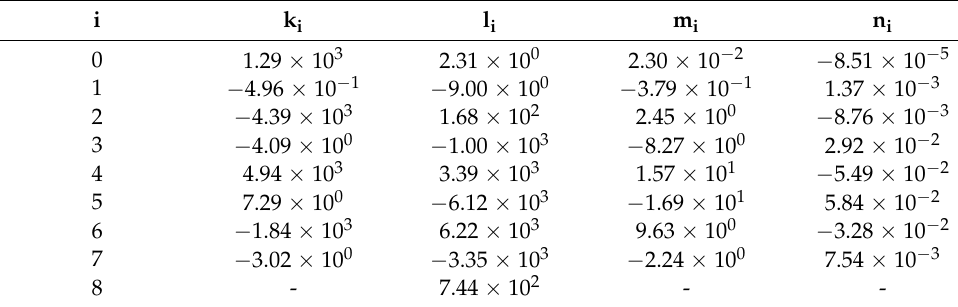
Table A31. Coefficients of the H 2 O-NaOH enthalpy equation.